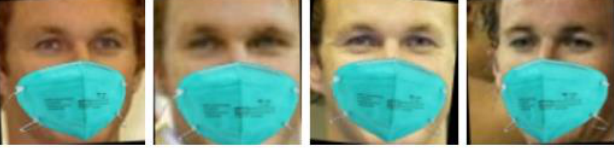
Figure18. ExampleimagesfromSMFRD(simulatedmaskedfacerecognitiondataset)dataset: simulated Figure 18. Example images from SMFRD (simulated masked face recognition dataset) dataset: masked images. simulated masked images.